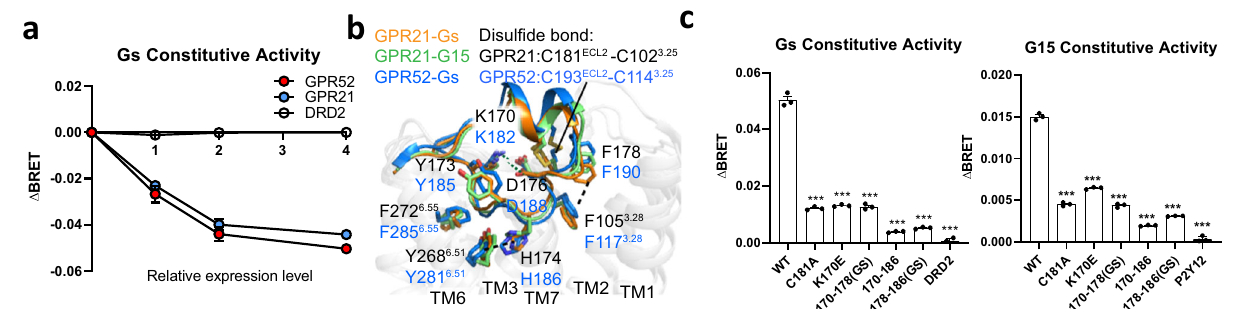
Fig. 2 | Analysis of ECL2 in the orthosteric pocket. a Comparison of constitutive activitiesof WTGPR21 and WT GPR52 inGssignaling measured byBRETassay (see Methods). Data were from three independent experiments. DRD2 was used as a negative control(white). Δ BRET:thechange ofbioluminescenceresonanceenergy transfer value. b Close-up view of the ECL2 in the orthosteric binding pocket between GPR21-Gs (orange), GPR21-G15 (green) and GPR52-Gs (blue, PDB: 6LI3). Key residues are shown as sticks. Salt bridges and π - π interactions are shown as green and black dashed lines, respectively. c Constitutive activities of WT GPR21 and GPR21 ECL2 mutants in Gs (left) and G15 (right) signaling measured by BRET